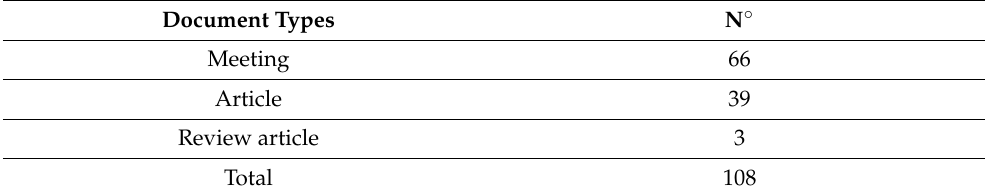
Figure 2. Number of publications and citations per year (2012–2022).